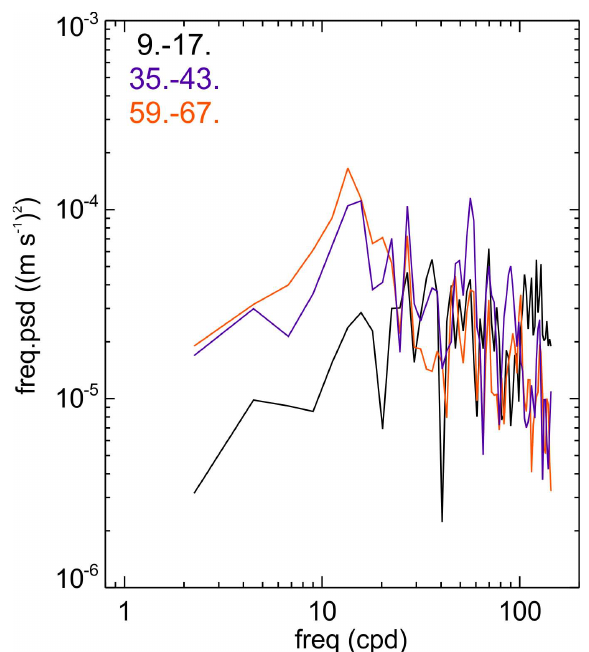
Fig. 10. Spectra of ADCP-derived vertical velocities from depths 9–17, 35–43m and 59–67m. The timeseries were 72h long and the spectra are shown scaled by the frequency vector to provide an area-preserving